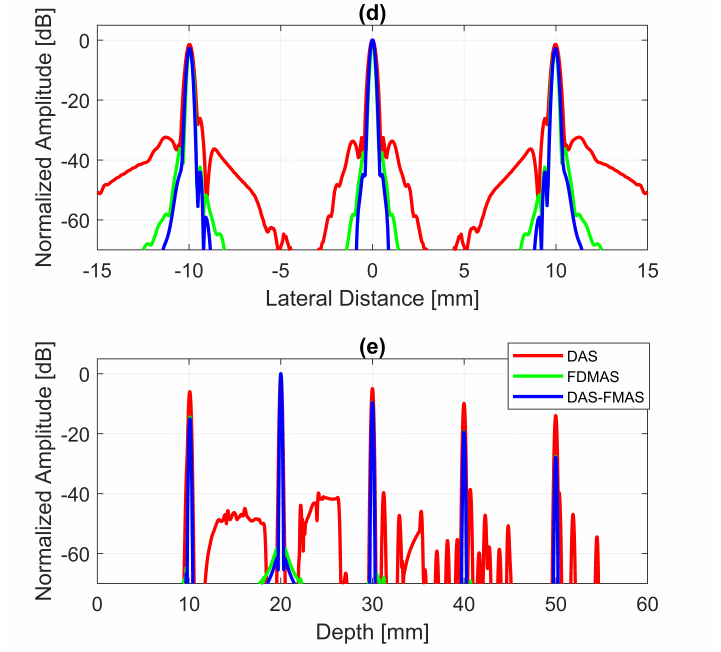
Figure 5. Point targets compound PWI B-mode images beamformed with ( a ) DAS, ( b ) FDMAS and ( c ) DAS-FMAS, N = 3 ( − 12 ◦ , 0 ◦ , + 12 ◦ ). The lateral beam profile at the depth of 50 mm and the axial beam profile at x = 0 mm are shown in ( d , e ) for all three beamforming techniques (DAS, FDMAS and DAS-FMAS).